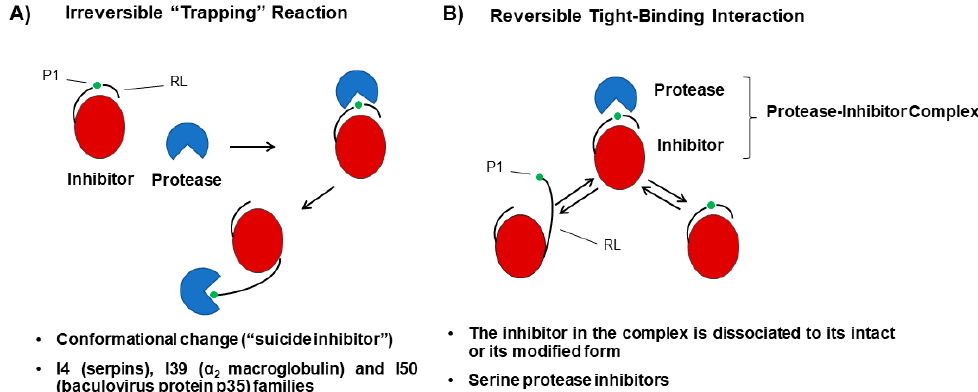
Figure 1. Mechanisms of protease-inhibitor interactions. ( A ) Irreversible “trapping” reactions. The protease–inhibitor interaction induces the cleavage of an internal peptide bond in the inhibitor triggering a conformational change. This reaction is not reversible, and the inhibitor never recovers its initial structure. For this reason, the inhibitors that participate in trapping reactions are also known as suicide inhibitors. The inhibitors never recover the initial structure. ( B ) Reversible tight-binding interactions. The inhibitor interacts with the protease active site in a similar way to the enzyme-substrate interaction. The protease-inhibitor complex co-exists in a stable equilibrium among the intact form of the inhibitor and the modified forms of the inhibitor where the peptide bond of the reactive site is cleaved. Therefore, the inhibitor in the complex is dissociated to its intact or its modified form. P1: PI reactive site; RL: reactive loop.